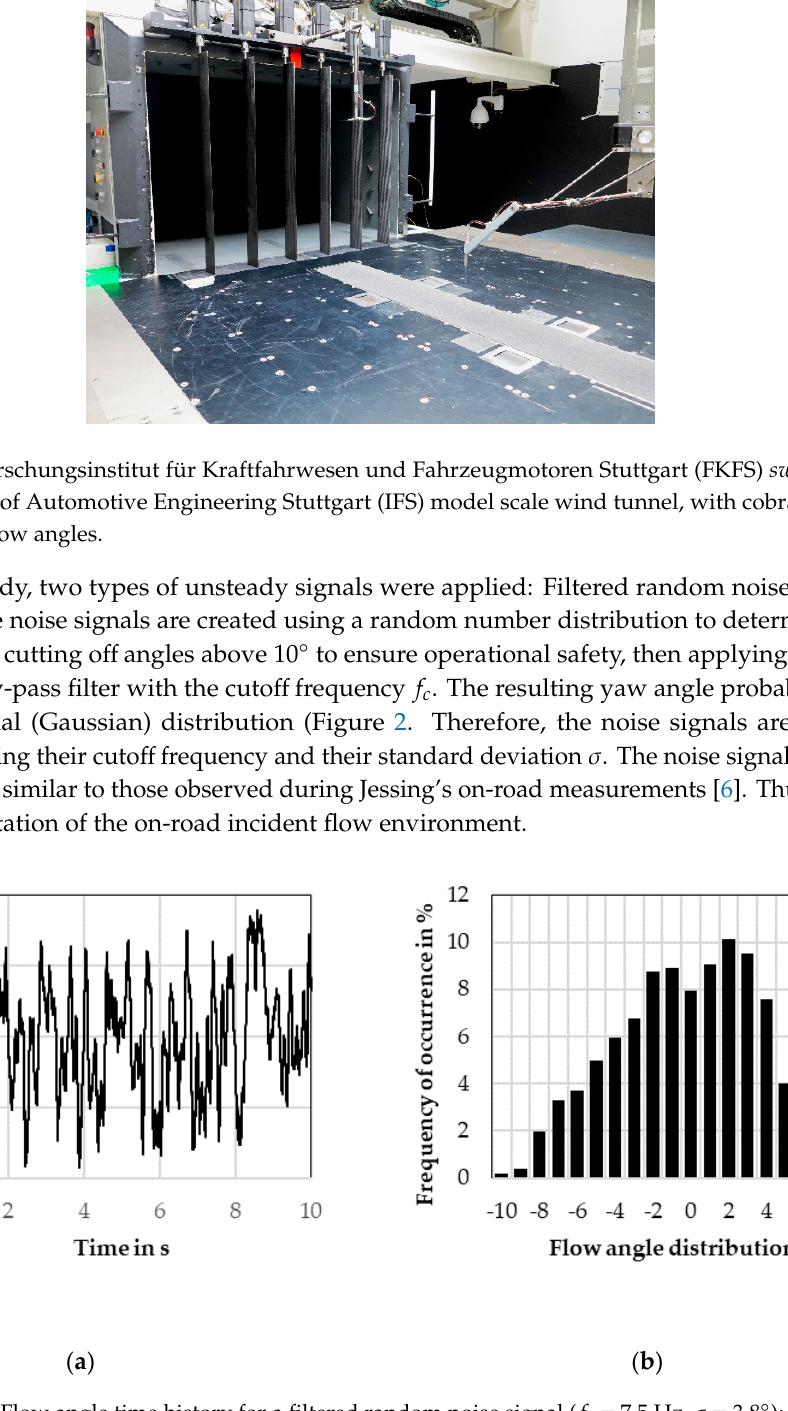
Figure 2. ( a ) Flow angle time history for a filtered random noise signal ( f c = 7.5 Hz, σ = 3.8 ◦ ); ( b ) Flow angle probability distribution for the same signal.